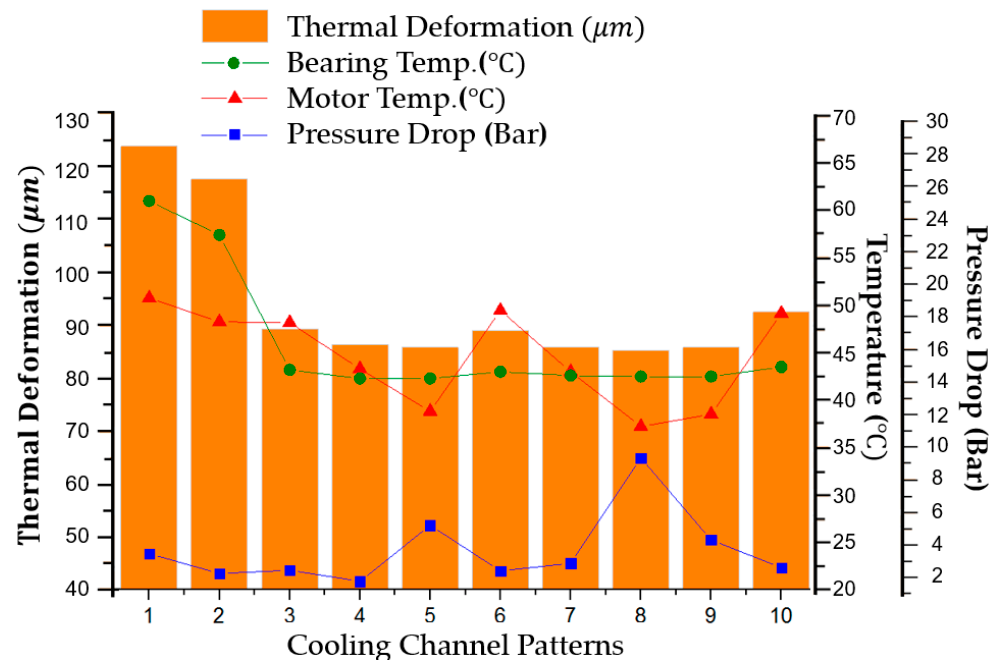
Figure 8. Simulation results of spindle thermal deformation and cooling channel pressure drop. Table 3. Summary of simulation results of spindle thermal deformation and cooling channel pressure drop.